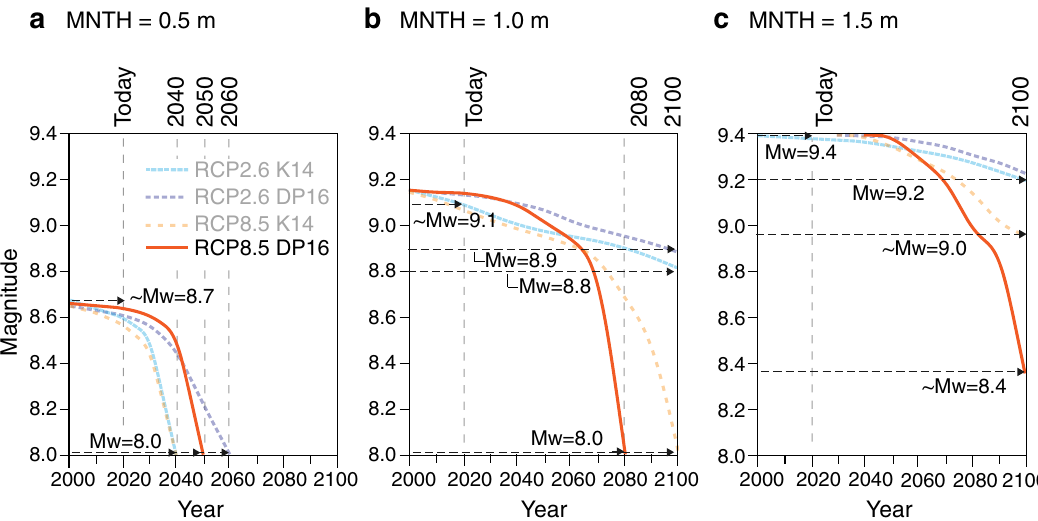
Fig. 4 Plots showing the earthquake magnitude that produces tsunamis that have a 50% chance of exceeding de fi ned maximum nearshore tsunami heights (MNTH) as a function of time. We examined three MNTH: a 0.5 m (measured multiple times during the historical period), b 1.0 m (two times larger than any historical event), and c 1.5 m (similar to a previous tsunami scenario conducted at the ports 16 and the highest storm-driven extreme sea level recorded at the ports 57 ). Table 2 The earthquake magnitude that has a 50% chance of generating a tsunami that exceeds fl ood heights of 0.5, 1.0, and 1.5 m today (2020) and in the year 2040*, 2050**, or 2060*** (for 0.5 m fl ood heights) or 2100 (for 1.0 m MNTH and 1.5 m MNTH) under the four RSLR projections